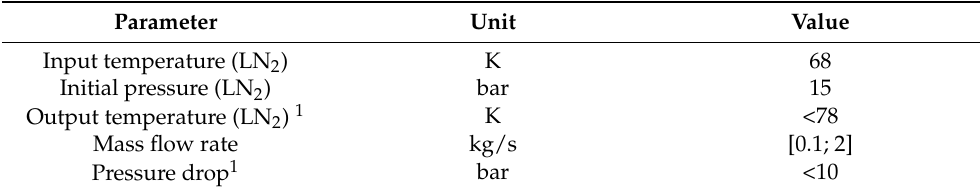
Table 5. Thermal and hydraulic parameters used for cable sizing.